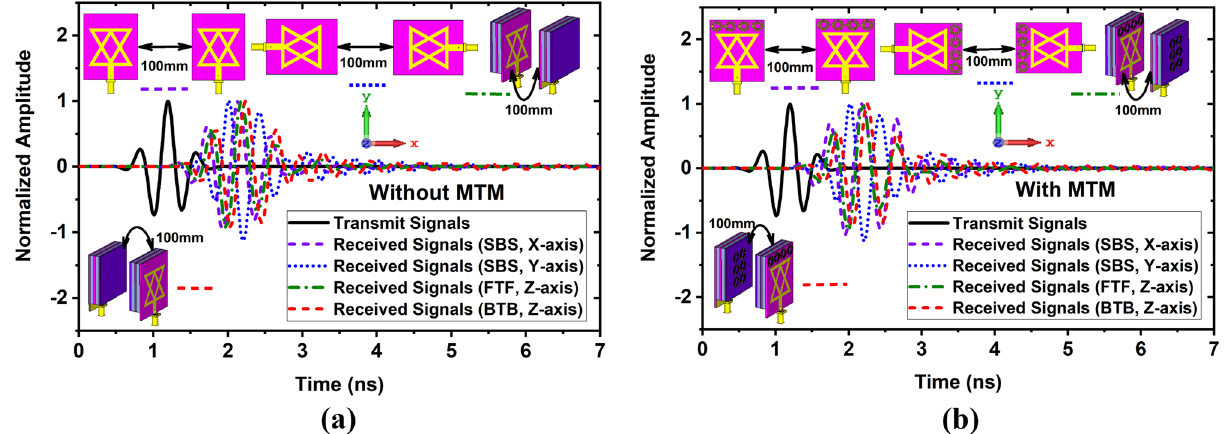
Figure 15. Normalized received signals in four orientations: ( a ) Without MTM; ( b ) With MTM.